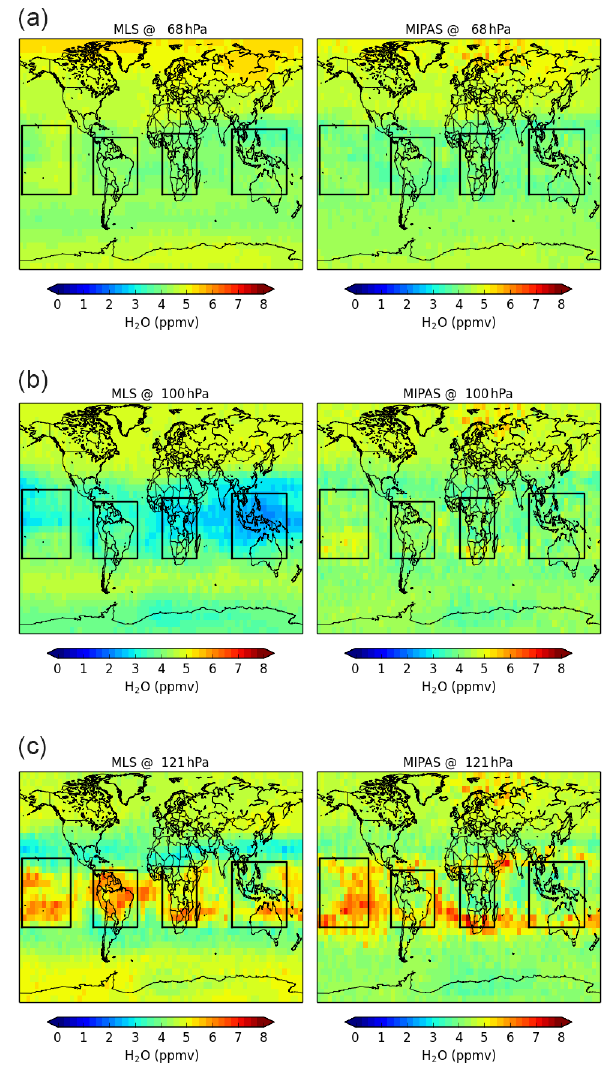
Figure 1. (a) Monthly averaged H 2 O fields at 68hPa in January 2012 in the MLS (left) and MIPAS (right) observation space (in space and time coincidence with MLS and MIPAS observations, respectively). (b) Same as the upper panel but at 100hPa. (c) Same as the upper panel but at 121hPa.